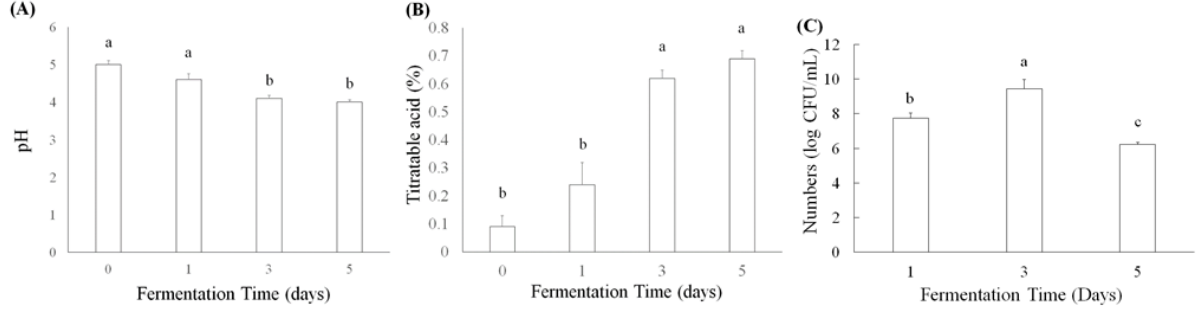
Figure 1. The variations of ( A ) pH, ( B ) titratable acid, and ( C ) microbial numbers in L. acidophilus BCRC14079-fermented mango after 1, 3, and 5 days, respectively. Data are shown as means ± SD ( n = 3). A significant difference was shown by various letters ( p < 0.05).